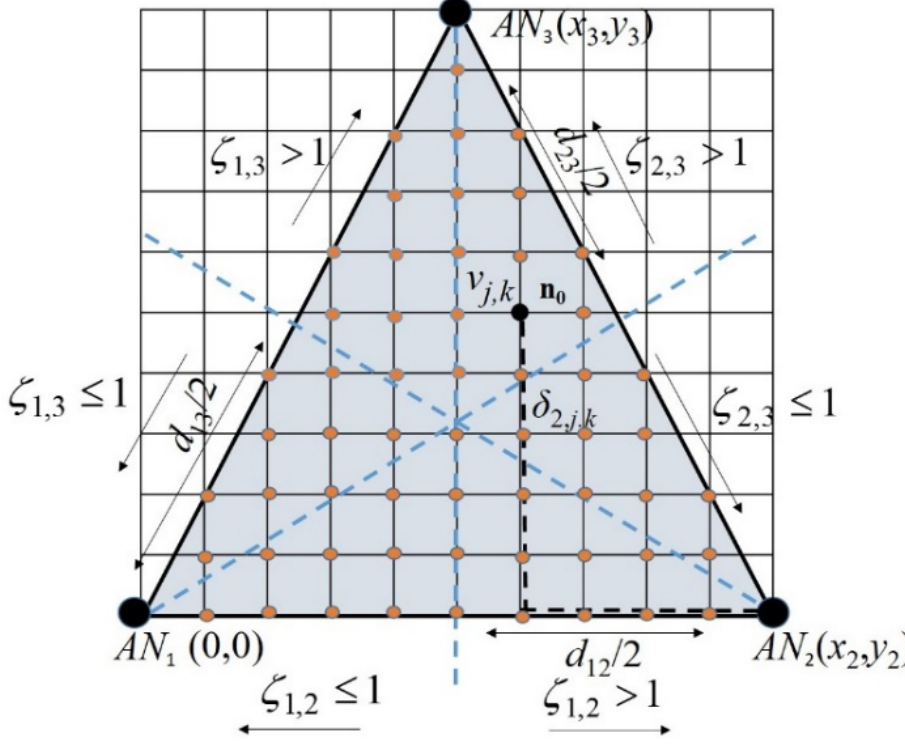
Figure 1. A 2D scenario for three ANs in a triangle.